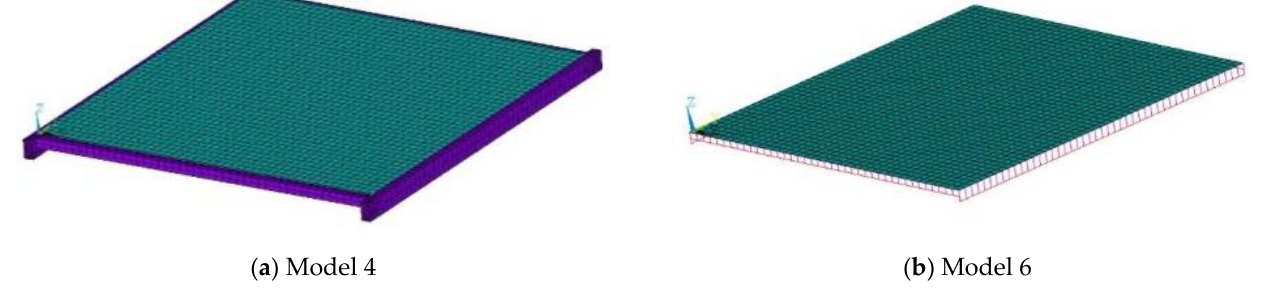
Figure 8. Simplified calculation model. Table 5. Calculation results of simplified model for sample A.